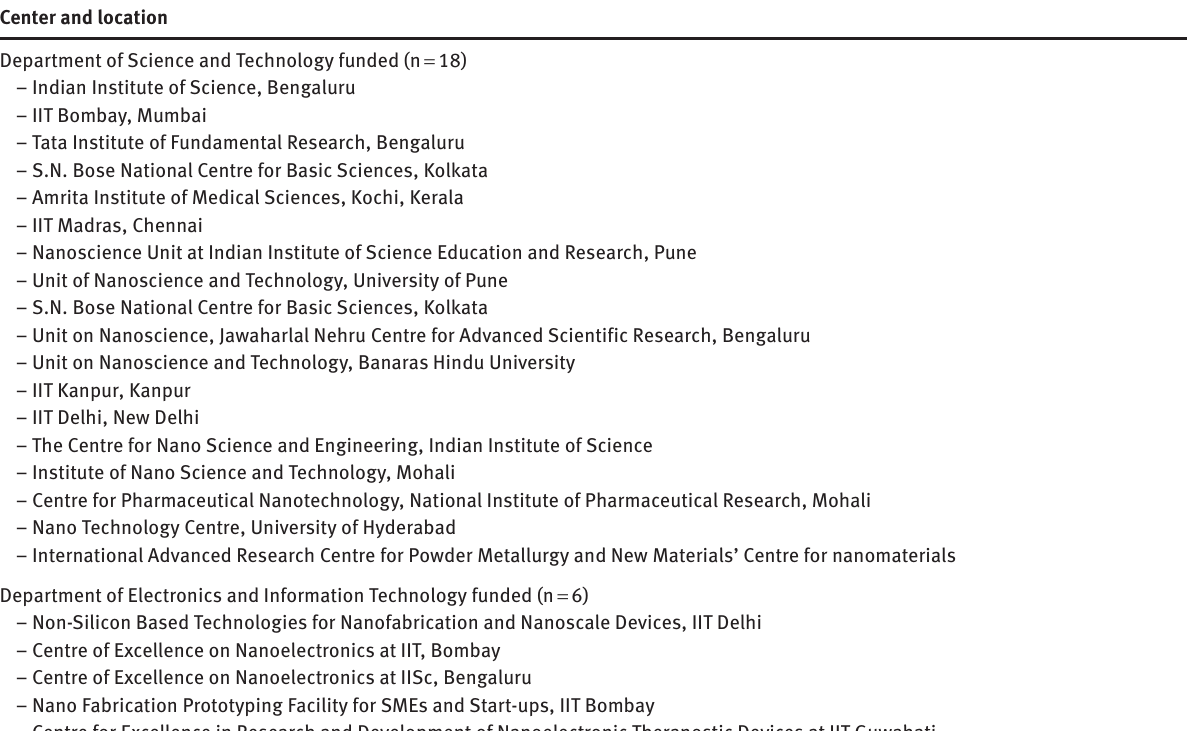
Table 3: A list of special centers established with research focus on nanotechnology in India (source: compiled by authors from websites of DBT, DST, ICMR, MHRD,